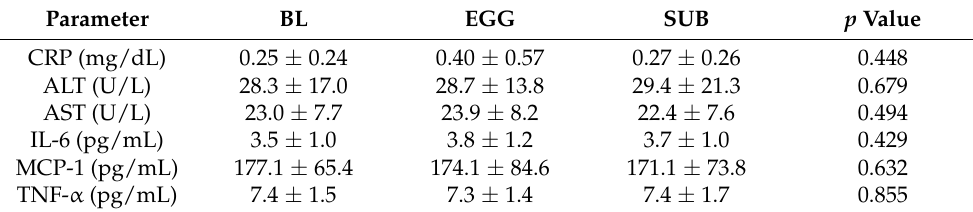
Table 1. Plasma concentrations of CRP, Liver Enzymes (ALT, AST), and cytokines (IL-6, MCP-1, TNF- α ) at baseline (BL) and during the EGG (egg) and SUB (egg substitute) periods *. Parameter BL EGG SUB p Value 0.25 ± 0.24 CRP (mg/dL)